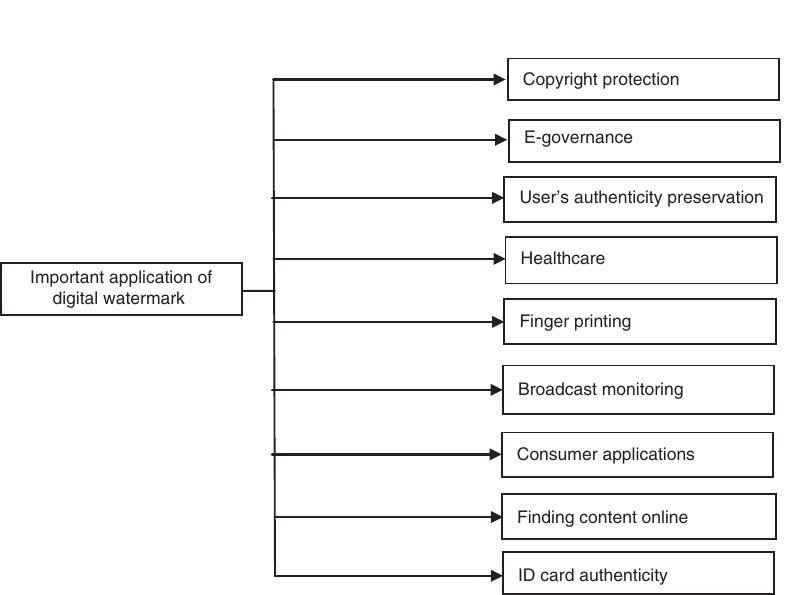
Figure 1: Potential Applications of Digital Watermarking.